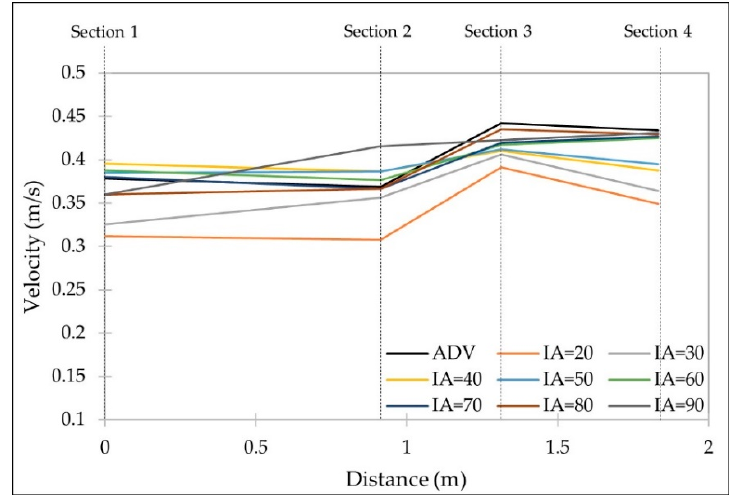
Figure 7. Measured Velocities obtained using LSPIV and ADV at Line-D (see Figure 5).